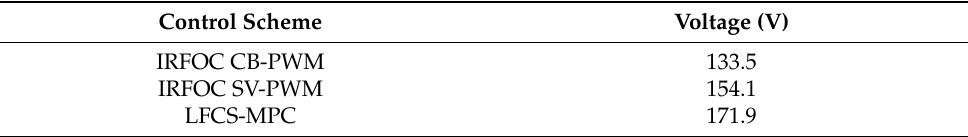
Table 8. Usage of the DC-link voltage in Test